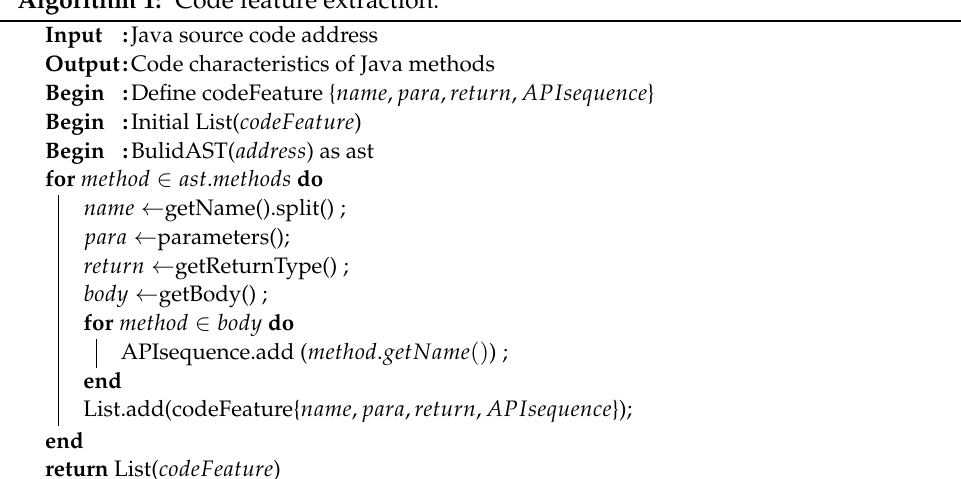
Algorithm 1: Code feature